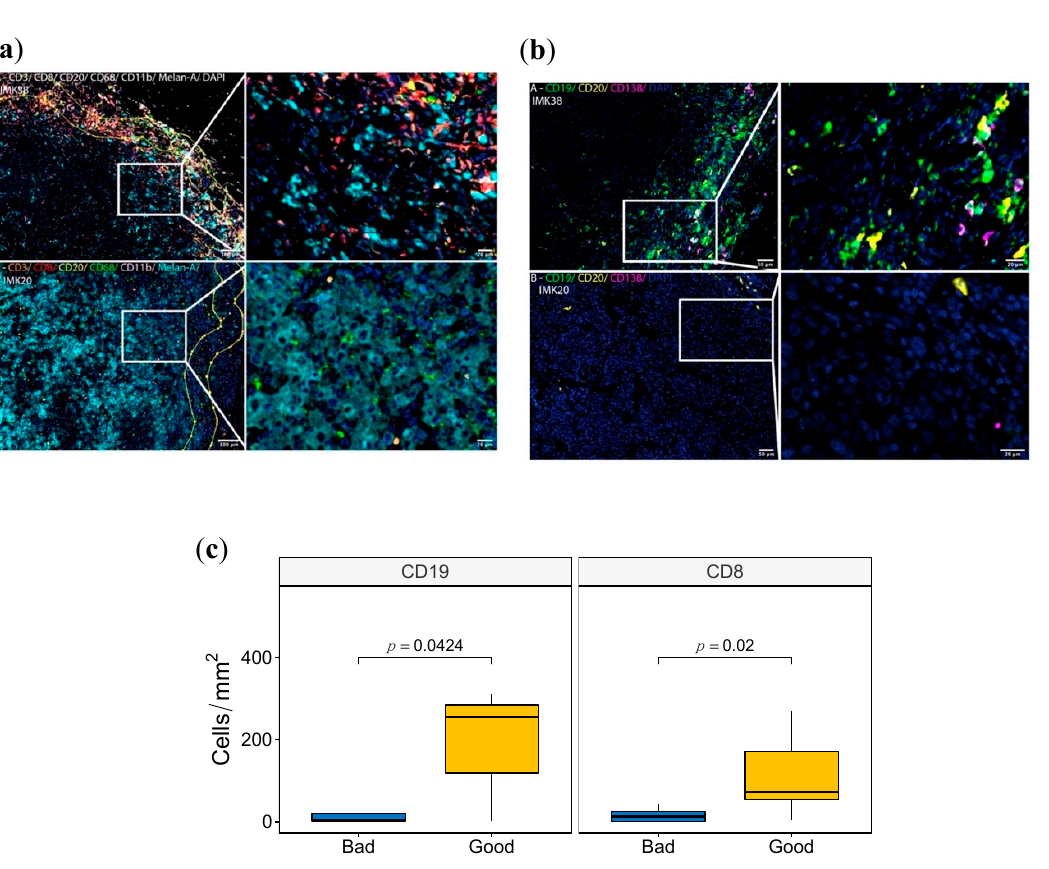
Figure 4. Multispectral Immunofluorescence tissue imaging of good and bad responder cases. ( a , b ) Fluorescence panels images of the markers CD11b, CD68, CD3, CD8, CD20, MELAN-A in ( a ) and CD19, CD20 and C138 in ( b ) of the patient IMK-20 (bad responder) and IMK-38 (good responder). ( c ) Boxplot with the Wilcoxon test comparing the density (Cells/mm 2 ) between good and bad responders of CD8 and CD19.